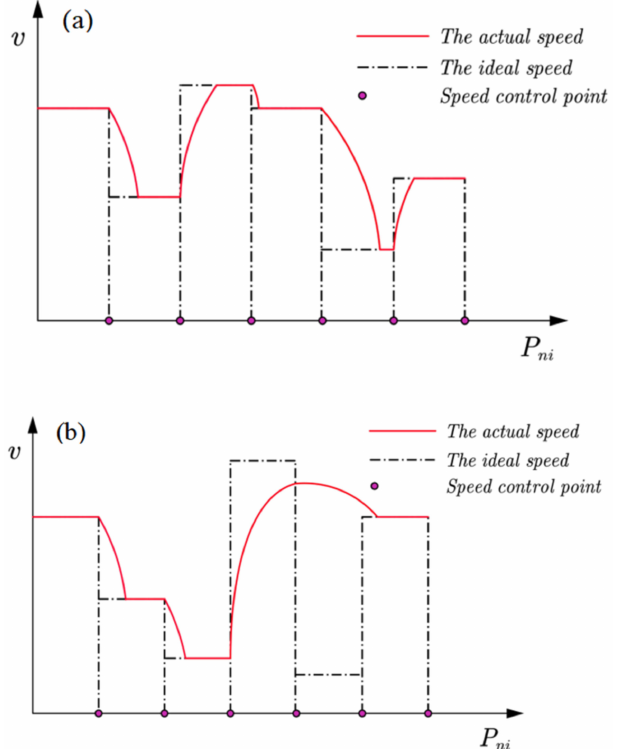
Figure 5. The dwell time error when the speed fluctuation between adjacent speed control points is small ( a ), and large ( b